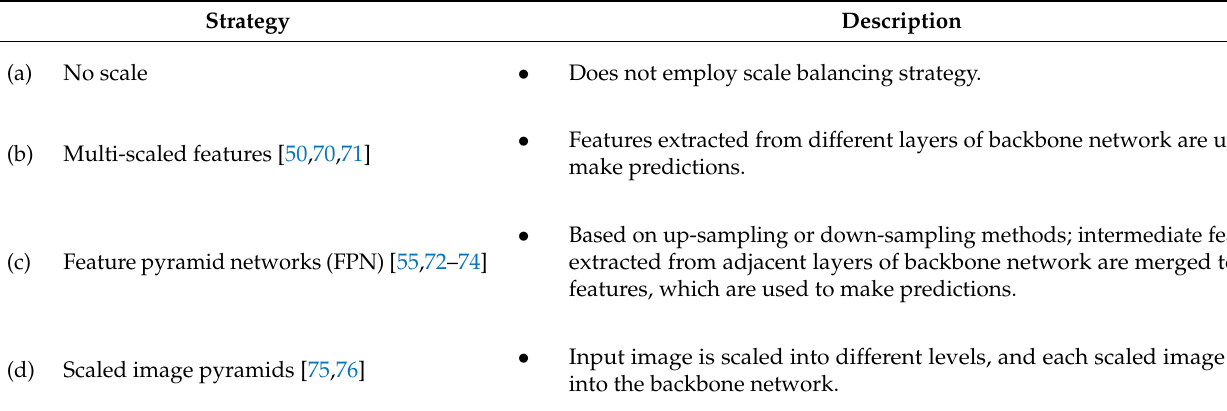
Table 6. List of scale-diversity strategies and